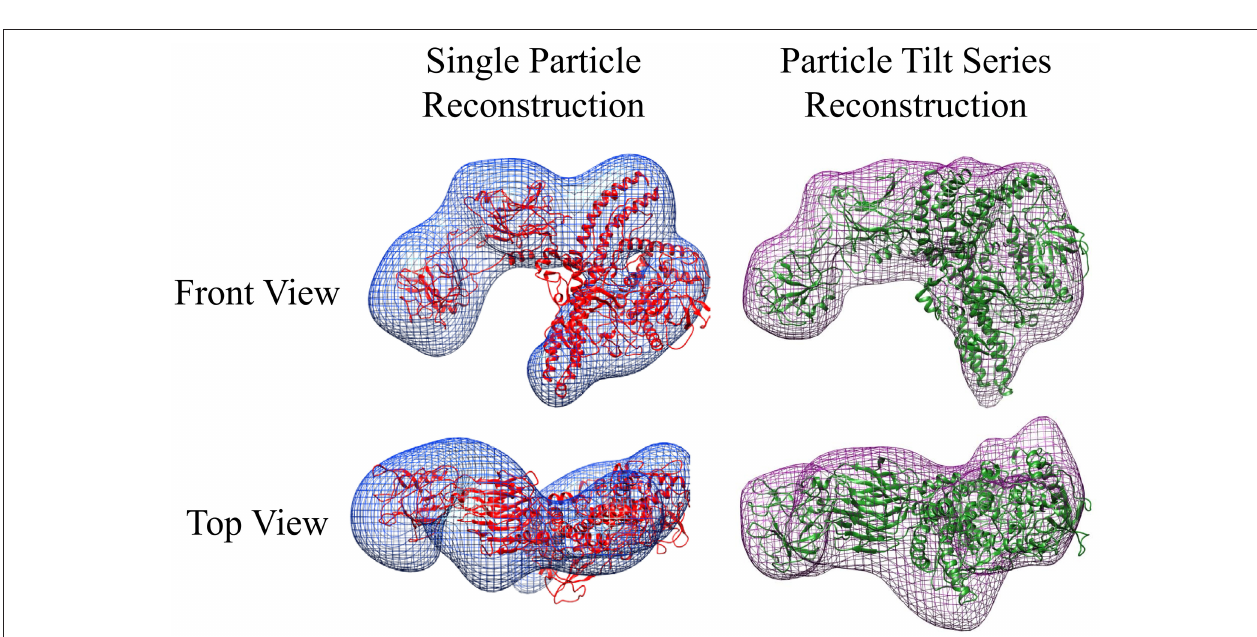
FIGURE 7 | Negative-stain EM Comparative Reconstructions: Single Particle Reconstruction & Particle Tilt Series Reconstruction. (Left) Blue envelope of traditional single particle reconstruction using micrographs from Figure 6 . Red ribbon structure of I-TASSER modeled protein fit using molecular dynamics into the envelope. (Right) Purple surface representation of reconstruction of 28 particles from tilt series acquisition. The green ribbon structure is the same I-TASSER fit into the map using MDFF. In this orientation, the receptor binding domain is placed on the left in each reconstruction.